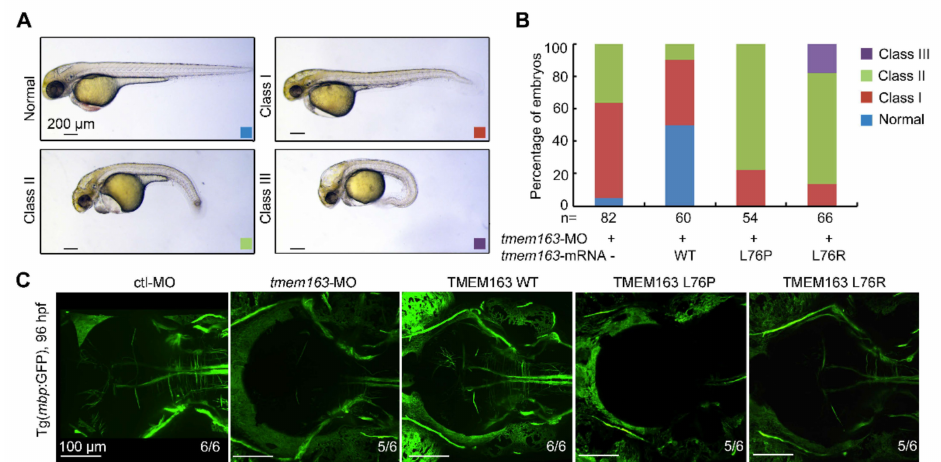
Figure 4. Functional analysis of TMEM163 mutations in zebrafish injected with translation-blocking morpholinos: ( A ) Representative images of the normal (blue), mild (red), severe (green) and pro- found (purple) phenotypes observed in the tmem163 -MO, MO+ TMEM163 WT, MO+ TMEM163 L76P, MO+ TMEM163 L76R injected groups at 48 hpf. Scale bar: 200 µ m. ( B ) Percentage of living em- bryos showing any phenotype at 48 hpf. Co-injection of tmem163 -MO with a human wild-type TMEM163 mRNA partially rescued phenotypes of tmem163 morphants such as degeneration of CNS, hydrocephalus, and bent tails, whereas injection of TMEM163 mRNA bearing the p.L76P or p.L76R mutation failed to rescue the phenotype. The number of embryos examined is listed under each bar. ( C ) The myelination in CNS is disrupted. Illustration of the Tg(mbp:GFP) larvae injected with control-MO, tmem163 -MO, TMEM163 WT, TMEM163 L76P, TMEM163 L76R at 96 hpf (dorsal views with anterior to the left). Both the mutations disorganize the myelin in the brain. The ratios of affected embryos are indicated. Scale bar: 100 µ